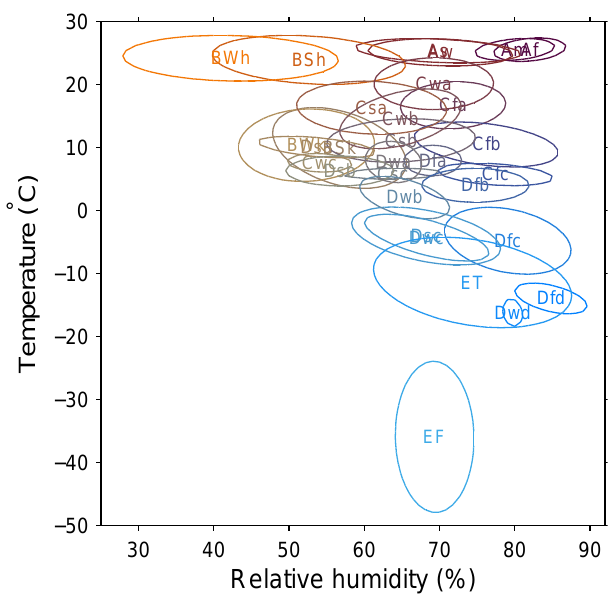
Fig. 1. Distribution of the K¨oppen-Geiger climate classes in the T , RH-space. Contours are fitted bivariate Gaussian densities provid- ing a measure of the spread within each